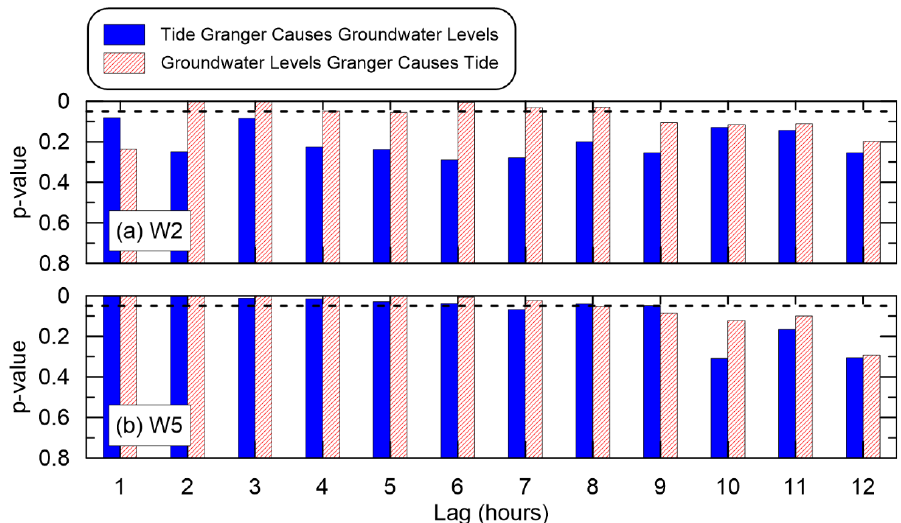
Figure 14. Results from Granger causality tests on wells ( a ) W2 and ( b ) W5 with respect to tide.